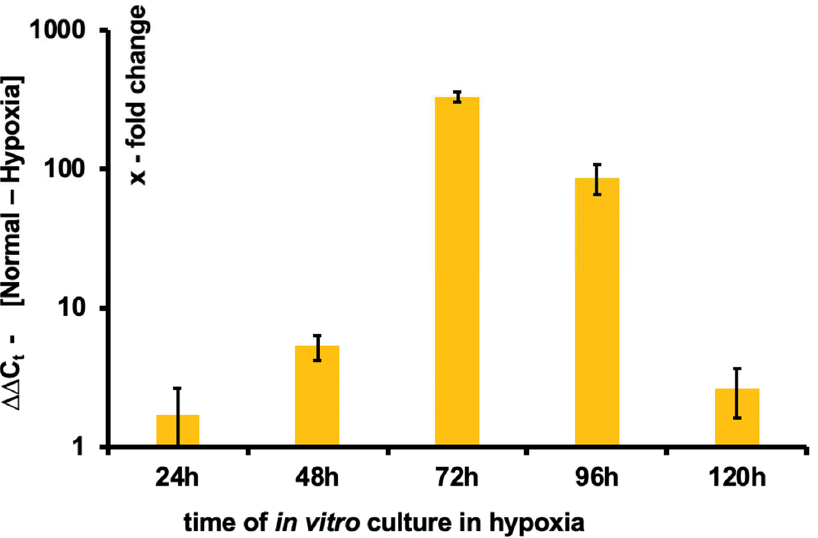
Figure 5. HIF1 α mRNA in response to hypoxia. Quantitative analysis of hypoxia-inducible factor 1 subunit alpha (HIF1 α ) by real-time polymerase chain reaction (qRT-PCR) shows a gradual up-regulation of HIF1 α mRNA in response to hypoxia. ∆ Ct is the difference in amplification cycles (Ct) between the gene of interest and the endogenous control ( β -actin) of a sample. ∆∆ Ct refers to the Ct difference in an experimental sample (hypoxia) and the same gene in the control condition (normoxia). Error bars represent an estimate of the SE of a log2 fold-change.